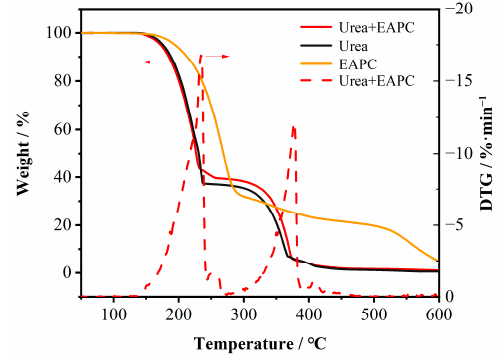
Figure 1. TG curves of CN, TA-CN-2 and EAPC.